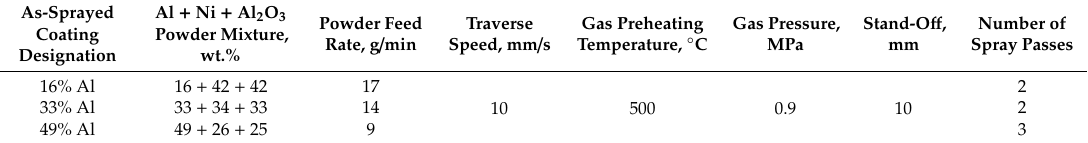
Table 1. Low pressure cold sprayed (LPCS) parameters.